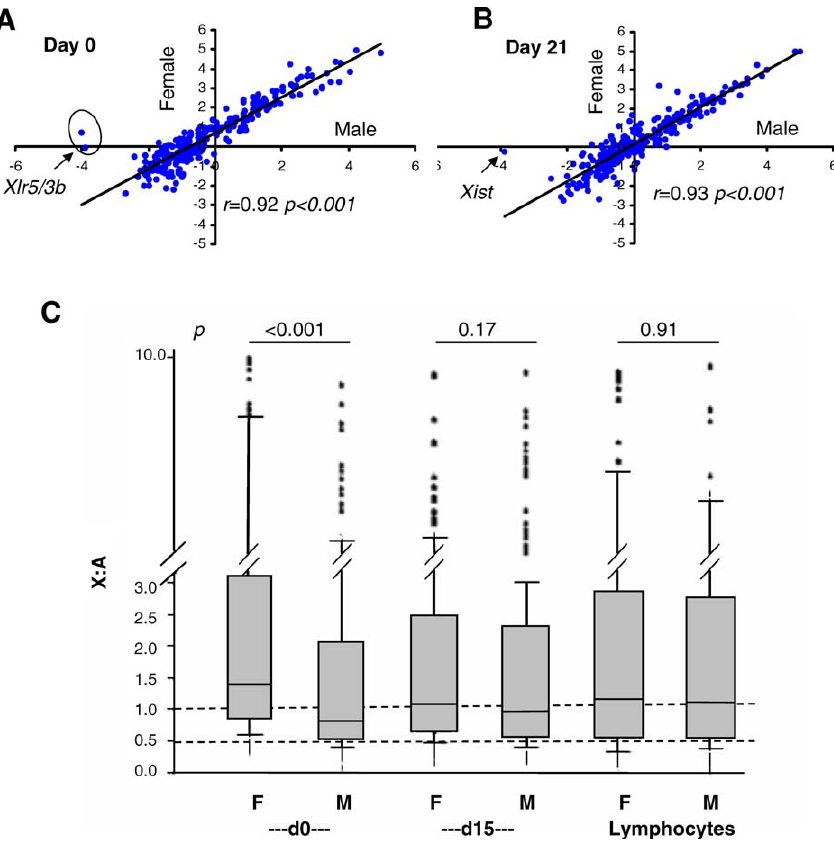
Figure 1. Expression of X-Linked Genes Is Consistently Higher in Female than in Male ES Cells Prior to Differentiation (A and B) Correlation in expression levels of X-linked genes between female ( y -axis) and male ( x -axis) ES cells. The value for each of the 249 clones (180 genes) shown is expressed relative to the expression of autosomal genes (X:A ratio, log 2 scale). Two genes, Xlr3b and Xlr5 , showed female-specific expression prior to differentiation (panel A). Xist is weakly expressed overall, but relatively more strongly expressed in differentiated female ES cells than in males (panel B). Pearson product moment correlation coefficients ( r values) are shown, along with estimates of the probability of chance correlation ( p ) corrected for false discovery rate (FDR). (C) Box plots (linear scale) showing the distribution of expression of X-linked genes in female and male ES cells before (day 0) and after (day 15) differentiation and in lymphocytes. The box encompasses the 25th–75th percentile and the upper and lower lines represent the 10th–90th percentile. Outlying values are shown as individual dots. Data are from at least two biological